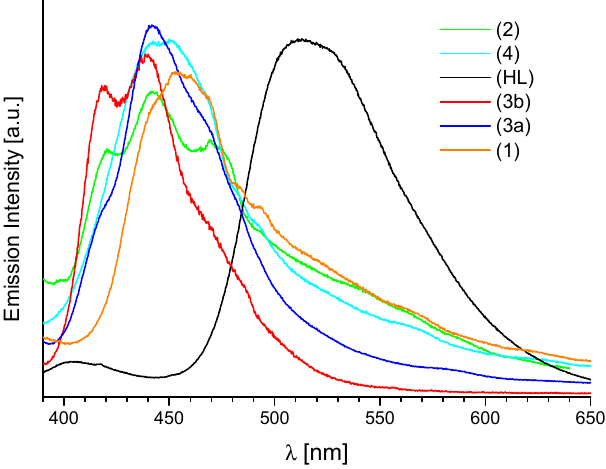
Figure 7. Normalized emission spectra of solid samples of HL ligand ( λ ex = 370 nm) and compounds (Sm) 1, (Eu) 2, (Tb) 3a 3b, (Dy) 4 ( λ ex = 368 nm).